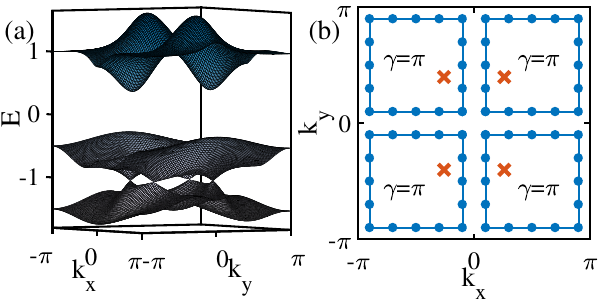
Fig. 4 Measurements of the Berry phase. a The theoretical energy spectrum of the Hamiltonian H 0 ð k Þ in Eq. (8) over the Brillouin zone, showing the existence of four Dirac points between the two lowest energy bands located at k = ( k x , k y ) ≈ (±0.26 π , ± 0.4 π ). (b) The experimentally (cid:4) (cid:5) (cid:4) measured Berry phases for the lowest energy eigenstate u 1 ð k Þ along four closed paths composed of discrete momenta (blue lines and points) in the Brillouin zone enclosing the corresponding Dirac points (red crosses). For each Dirac point, the measured Berry phase is γ = Fig. 5 Measurements of dynamical topological structures from quench dynamics. a The skyrmion-antiskyrmion structures for the vectors a ( k ) obtained by measuring the time-evolving state at t = π /2 under the nontrivial postquench Hamiltonian H ( k ) with m = 1. The skyrmion or antiskyrmion structures appear in each half of the 2D Brillouin zone, contributing a Chern number of ±1, respectively. b The skyrmion and antiskyrmion structure is directly associated with the nontrivial linking structure with a link and an antilink composed of the inverse images f (cid:3) 1 ð ^ p 1 Þ and f (cid:3) 1 ð ^ p 2 Þ in ( k x , k y , t ) space for any two distinct points ^ p 1 and ^ p 2 on S 2 . Here we take ^ p 1 ¼ ð 1 ; 0 ; 0 Þ and ^ p 2 ¼ ð(cid:3) 1 ; 0 ; 0 Þ . The red and blue arrows show the images of the experimentally measured evolving state through the Hopf map, which are close to the theoretical values marked by yellow and green arrows. c , d Quench dynamics for the trivial postquench Hamiltonian H ( k ) with m = 3. The vectors a ( k ) have a topologically trivial distribution and the inverse images of ^ p 1 and ^ p 2 do not link with each other. In a and c , the color bar describes a z , the component of the vectors a ( k ) along the z direction.